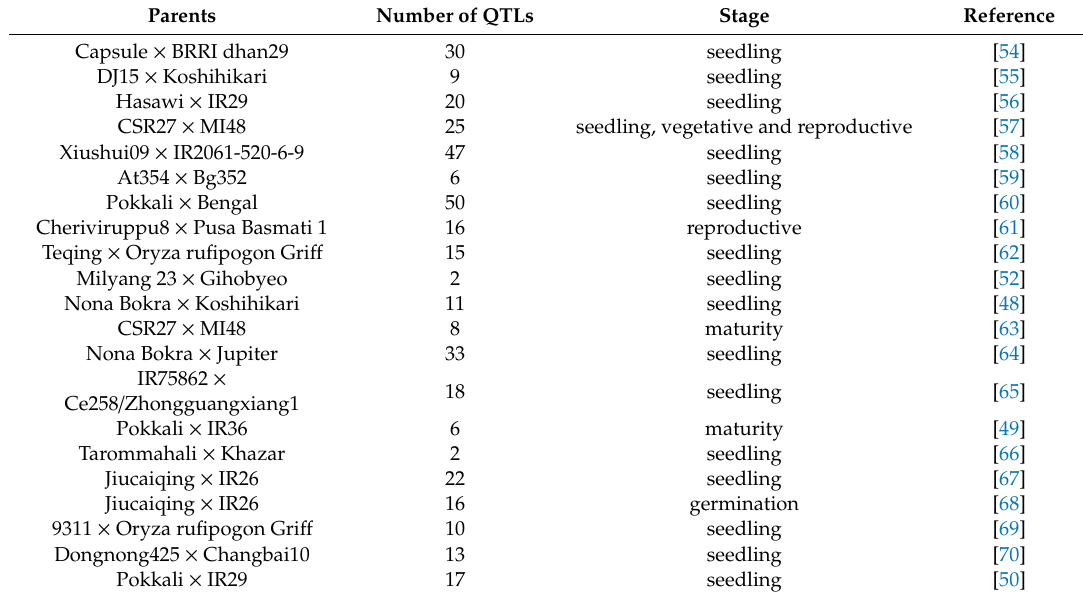
Table 2. Quantitative trait loci (QTLs) identified for salt tolerance in